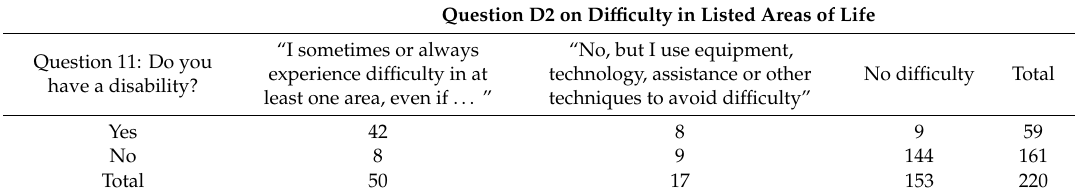
Table 5. Responses to D2 and Q11.